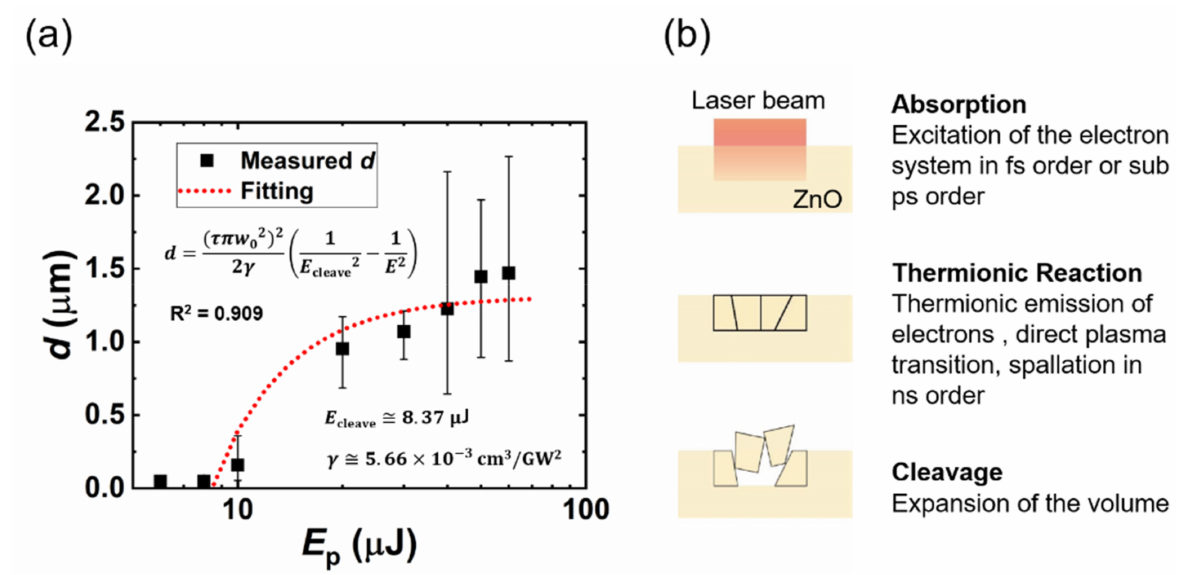
Figure 4. ( a ) The cleavage depth ( d ) (black squares) is plotted as a function of the pulse energy. The red broken line shows a fitting result based on a three-photon absorption model. The extrapolation to zero shows the laser-induced cleavage threshold energy ( E cleave ). ( b ) Image of the laser-induced surface-cleavage